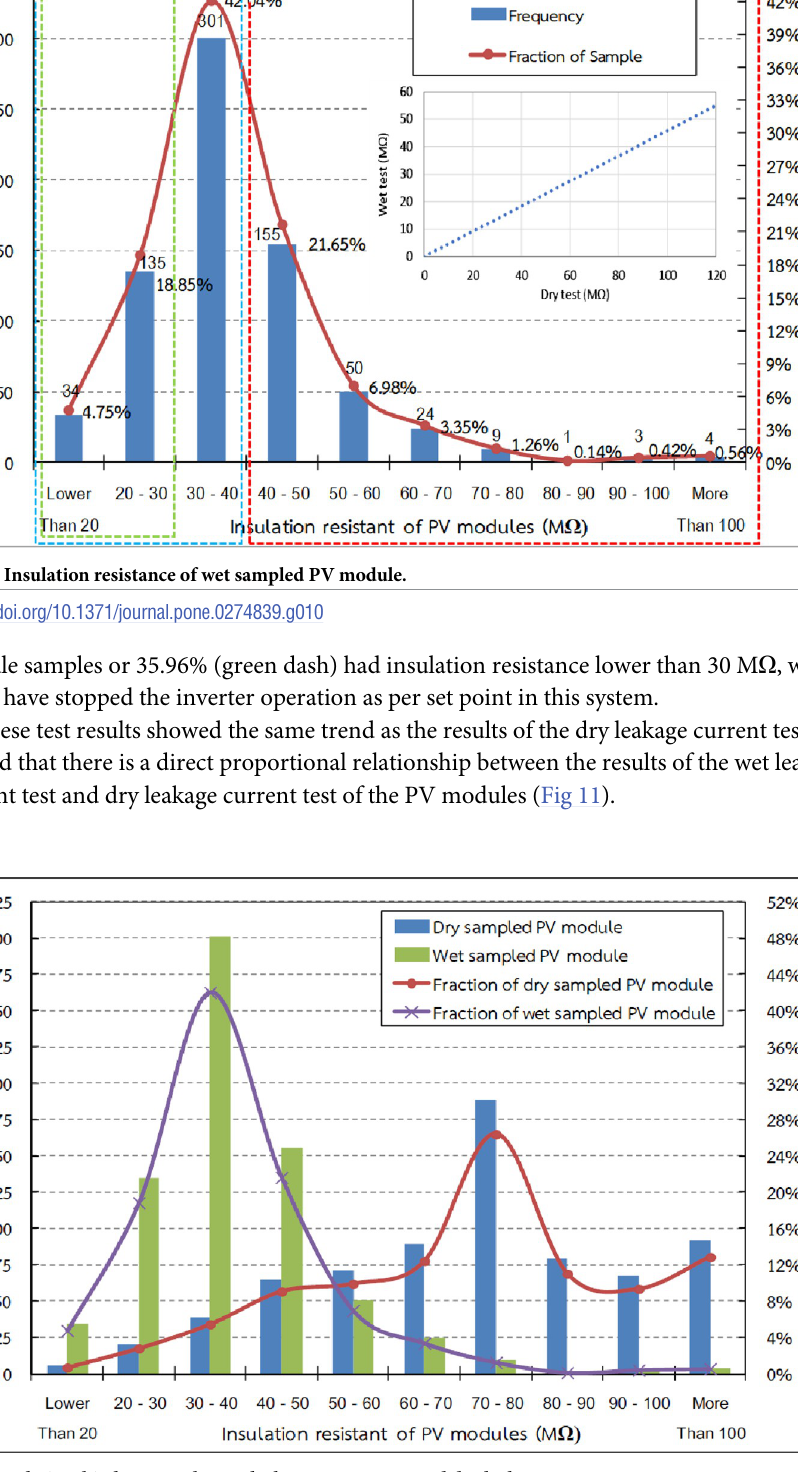
Fig 11. Relationship between the wet leakage current test and dry leakage current test.